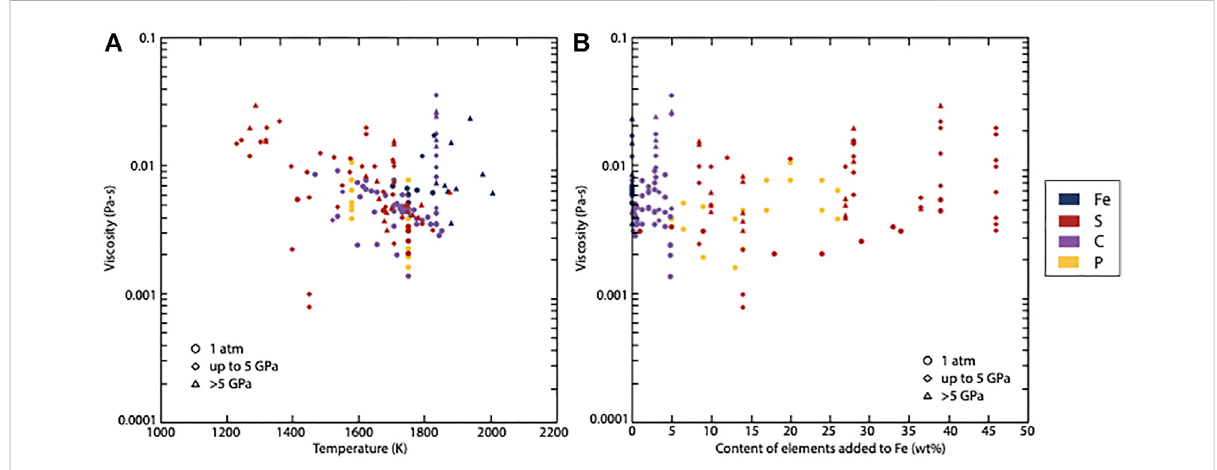
FIGURE 6 Viscosity of liquid iron and iron alloys from previous experimental studies as a function of temperature (A) and contentof elements added to Fe (B) . Data source: Barmin et al., 1970; Dobson et al., 2000; Funakoshi, 2010; Kono et al., 2015; Rutter et al., 2002; Secco et al., 2002; Terasaki et al., 2001, 2002, 2006; Urakawa et al., 2001; Vatolin et al., 1962; Vostryakov et al.,